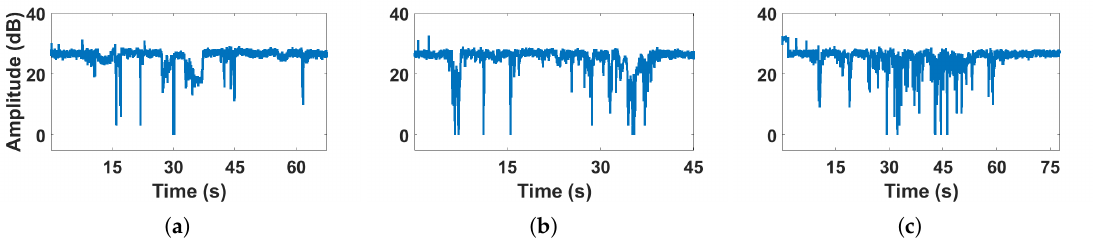
Figure 5. CSI amplitude of human motion activities ( a ) one person, daily activity; ( b ) two persons, daily activity; ( c ) two persons, intense